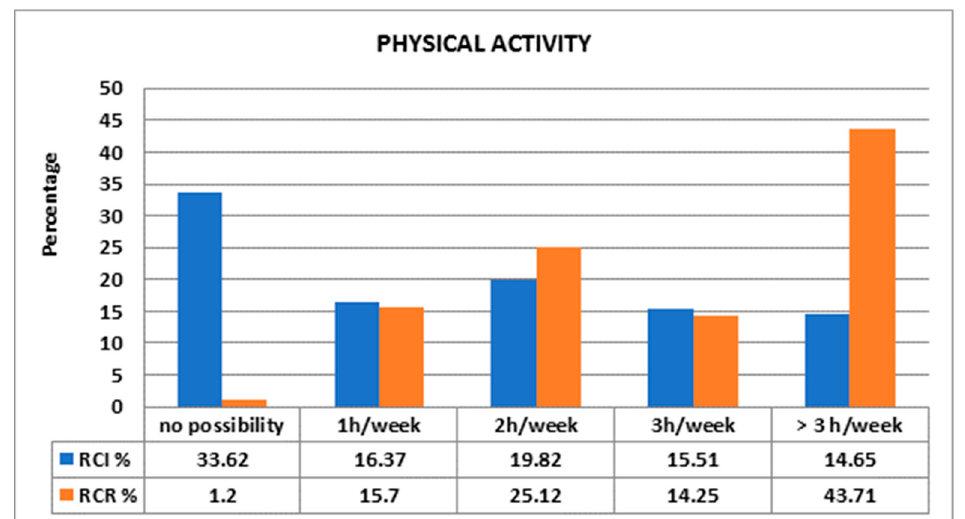
Figure 1. Comparison between parents’ employment statuses.